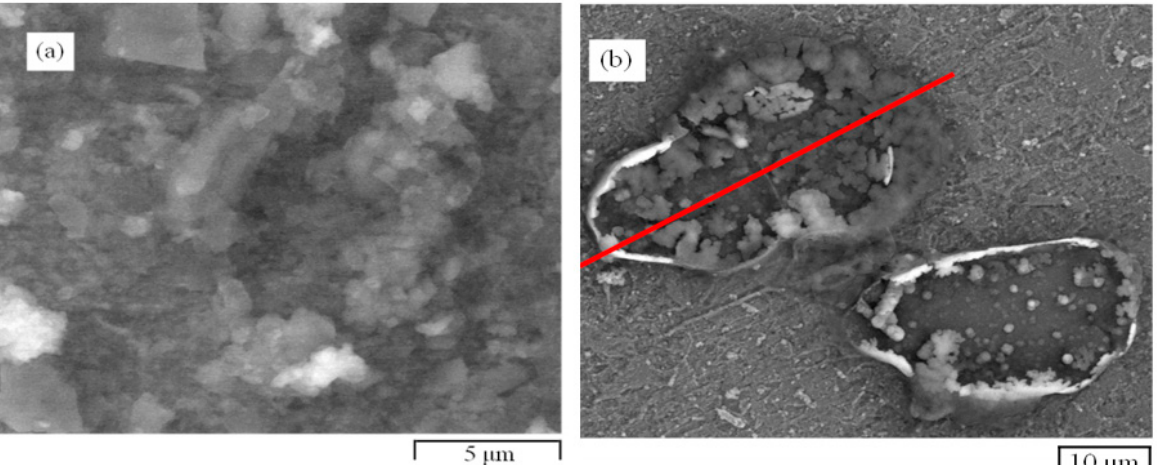
Figure 11. ESEM images of hydrated biofilm formed on carbon steel by a pure IRB culture following 72 h exposure to IRB and Postgate C without organic constituents: ( a ) amorphous corrosion product deposits containing carbon, oxygen phosphorous and iron. ( b ) SEM image of iron oxyhyrdroxide shell. FIB cross-section was carried out across the area indicated by the red line.